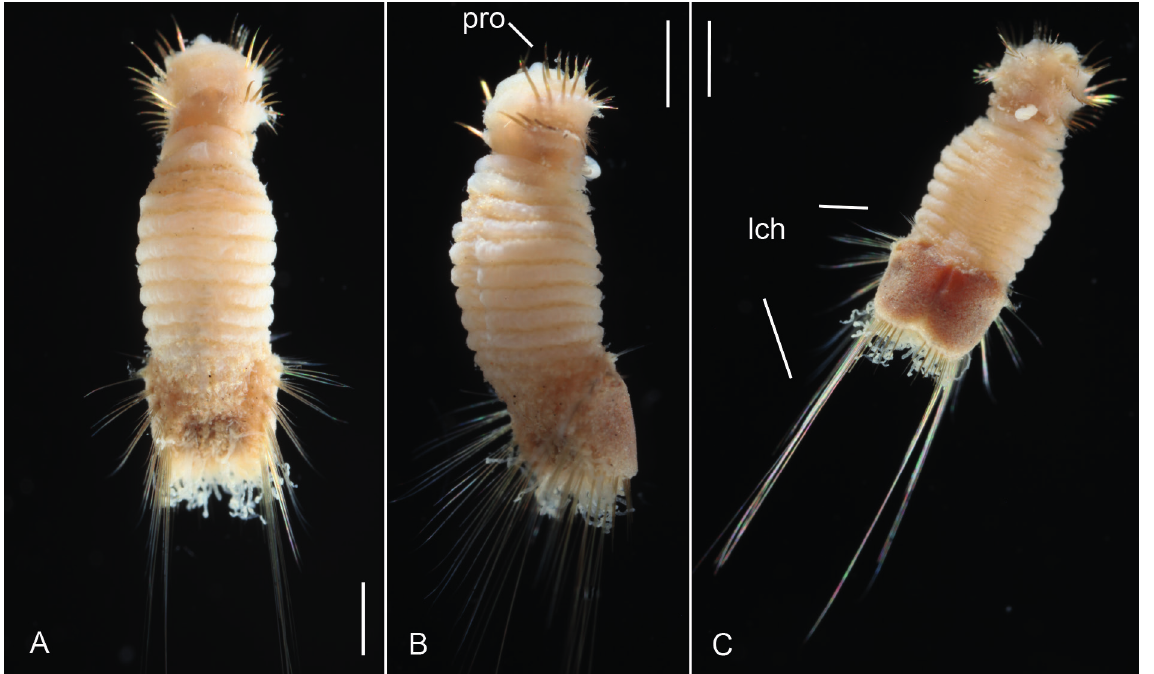
Fig. 2. Mauretanaspis longichaeta gen. et spec. nov., holotype (MNHN-IA-TYPE 2005). A . Dorsal view. B . Lateral view, right side. C . Ventral view showing length of posteriormost lateral chaetae. Abbreviations: lch = lateral chaetae; pro = prostomium. Scale bars: 1